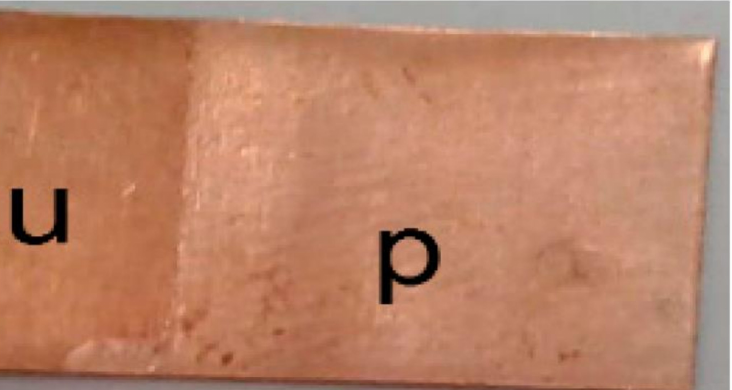
Figure 6. Photograph of the metal copper sheet before (u) and after (p) electropolishing in Ethaline at 0.18 V and 20 ◦ C for 10 min (reprinted with permission from ref. [45]; Copyright 2019 by the authors, licensee MDPI).